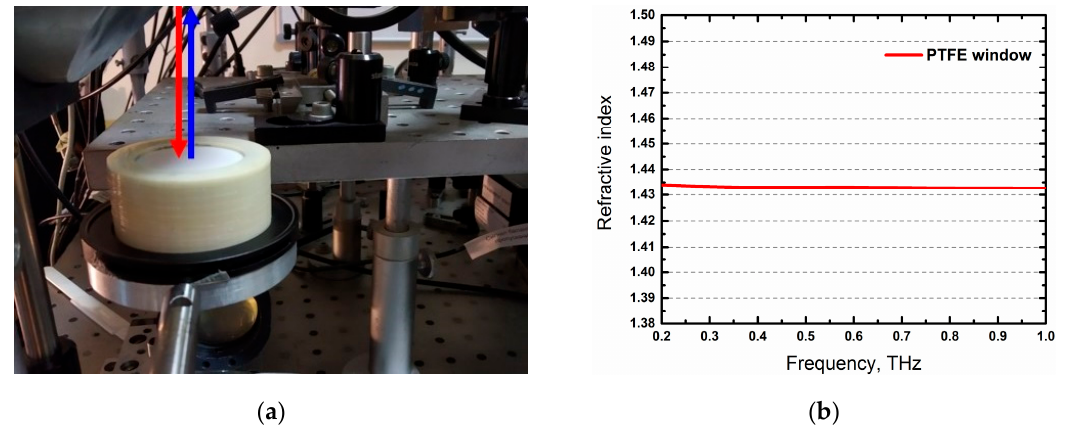
Figure 4. ( a ) The sample holder with the polytetrafluoroethylene (PTFE) plate used as a window and ( b ) refractive index of PTFE.